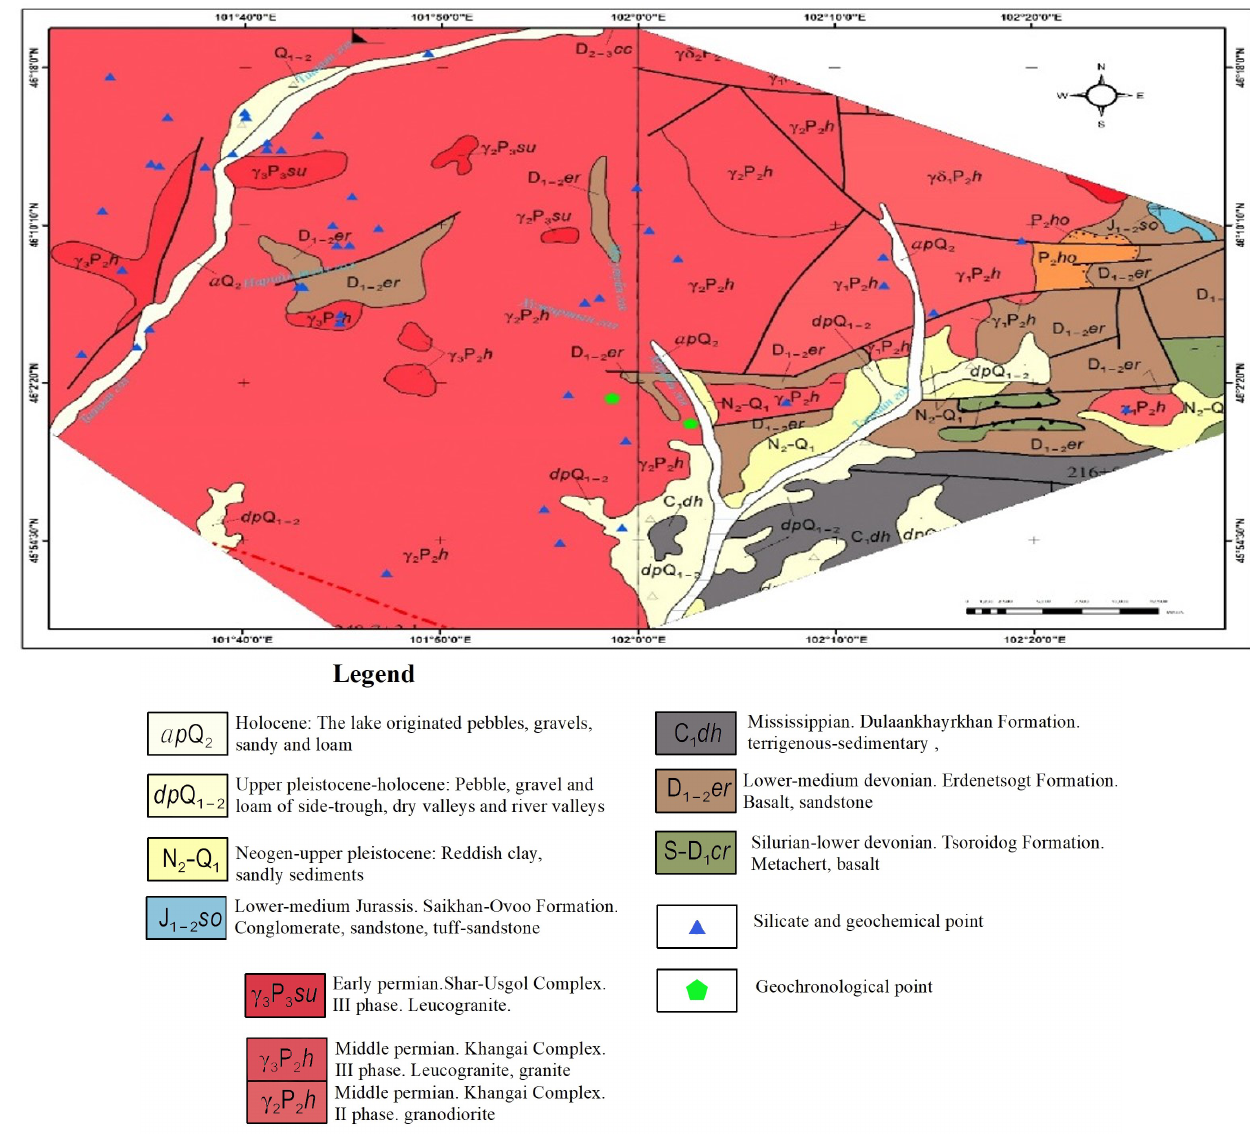
Fig. 2. Geological map of the study